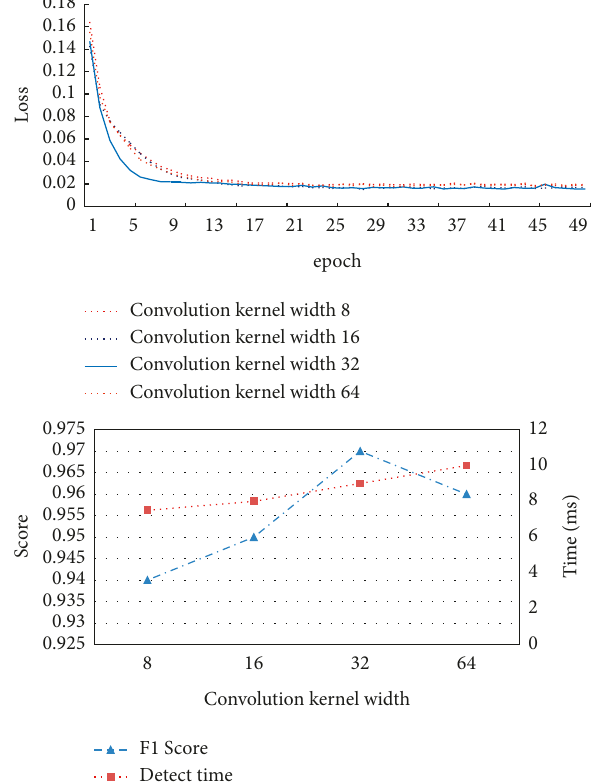
Figure 15: Performance of the model with different convolution kernel widths.